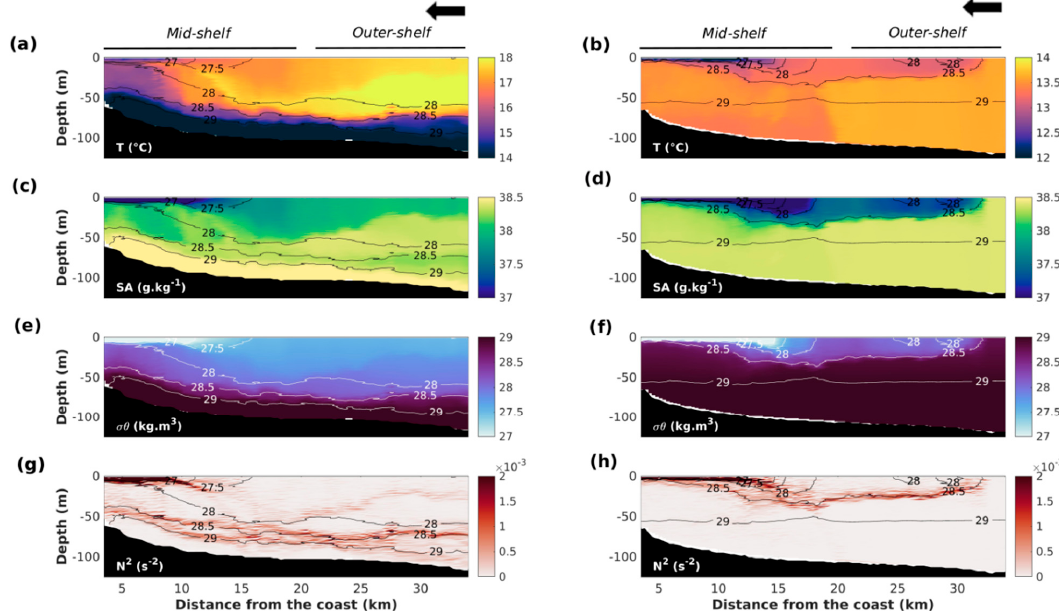
Figure 6. Hydrological variables: ( a , b ) temperature, ( c , d ) absolute salinity, ( e , f ) density anomalies, and ( g , h ) the Brunt–Väisälä frequency. The isopycnals are superimposed on all plots and indicated by black or white lines. The left panels correspond to autumnal conditions, from November 11 to 13, 2016. The right panels correspond to winter conditions, from February 5 to 7, 2017. The black arrow at the top of each panel indicates the direction of the glider’s motion.